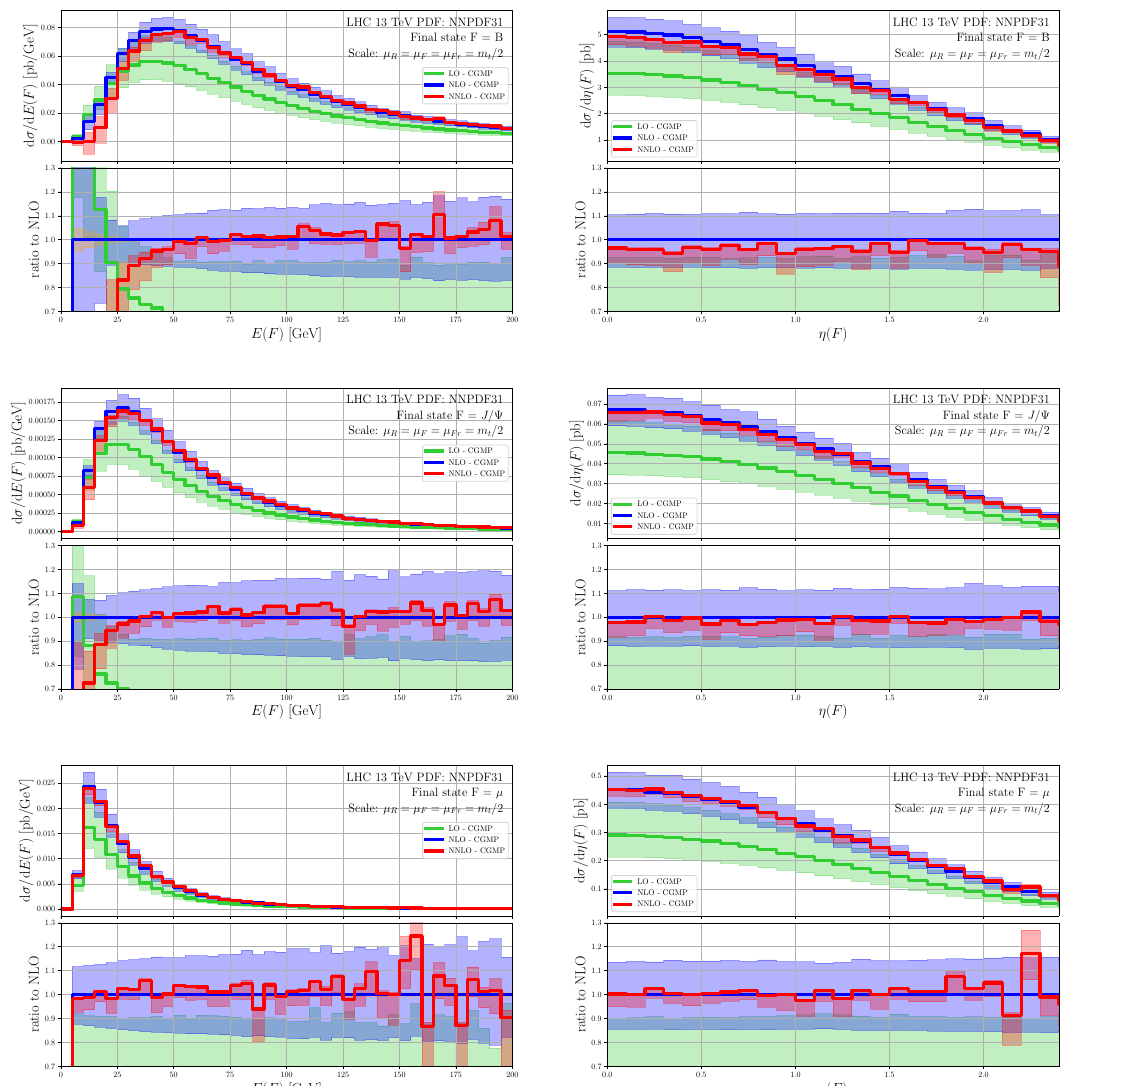
Figure 9 . The absolute E ( F ) (left column) and pseudorapidity | η ( F ) | (right column) distributions for F = B (top), F = J/ψ (middle) and F = µ (bottom). The prediction uses the fixed scale (3.2). Shown are the 15 point scale variation bands for LO, NLO and NNLO as well as the NPFF r.m.s. uncertainty band (in yellow, shown with respect to the